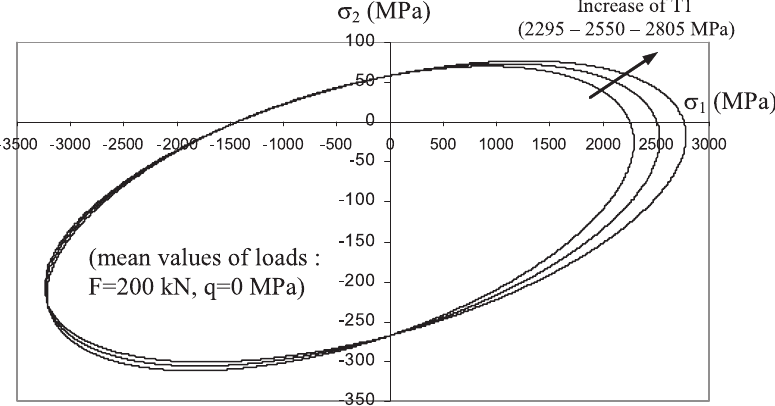
Fig. 12. Failure criteria according to the limit stress T 1 (carbon-epoxy).